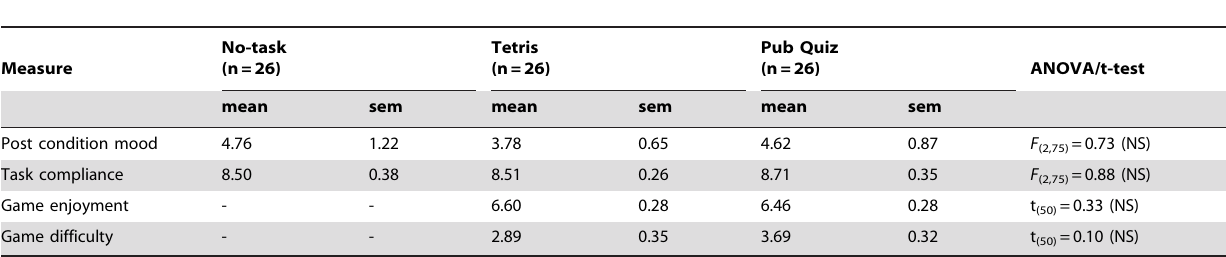
Table 9. Experiment 2 means and statistics for mood assessment, task compliance, game enjoyment and difficulty for the 10-min experimental manipulation which did not differ between